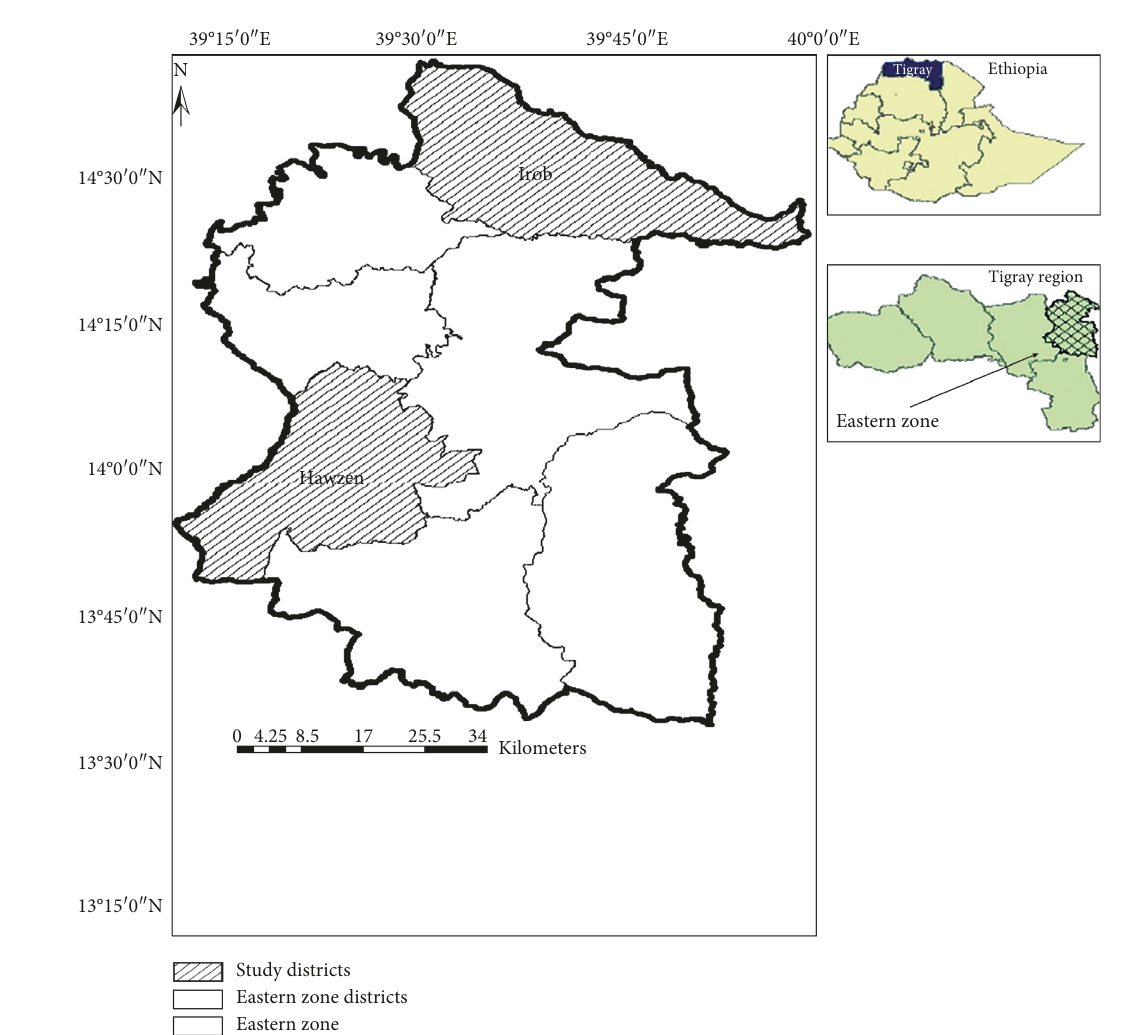
Figure 1: Map of the study